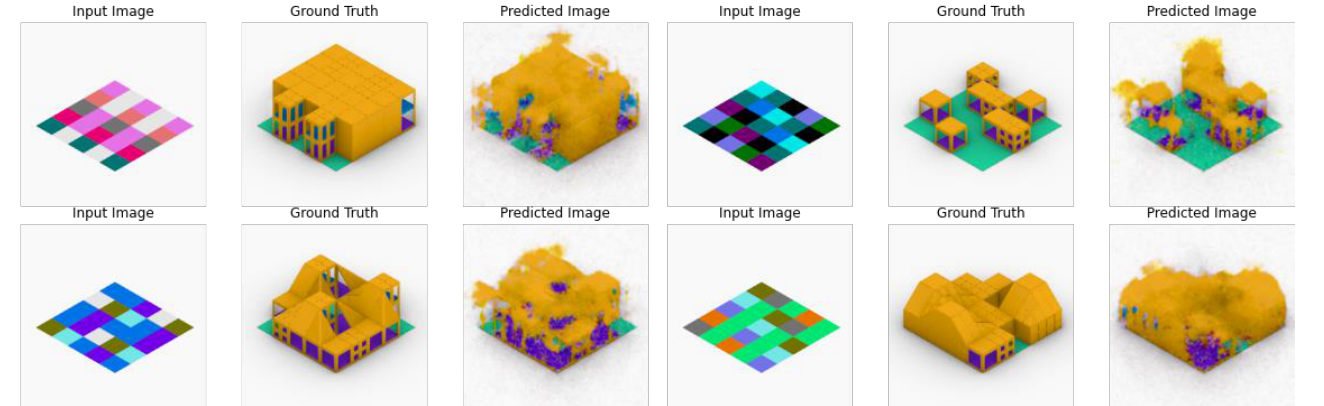
Figure 8. Captures from test D01.